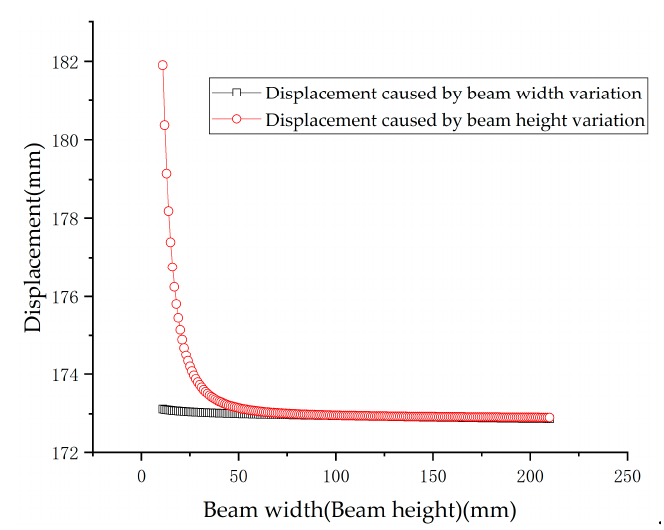
Appl. Sci. 2019 , 9 , x FOR PEER REVIEW Figure 3. Sensitivity curve of B S height and width. Figure 3. Sensitivity curve of B S height and width.